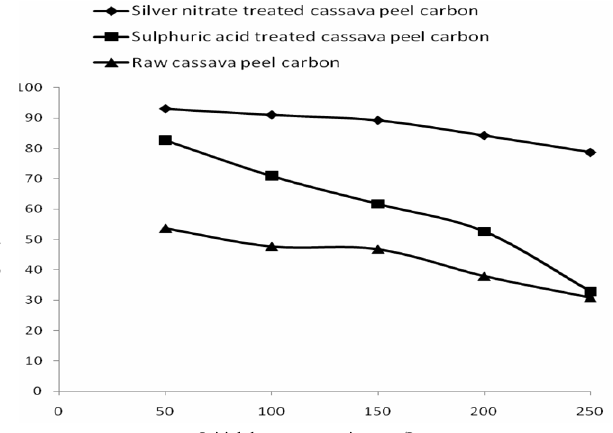
Figure 1. Effect of initial methyl red concentration on the dye adsorption